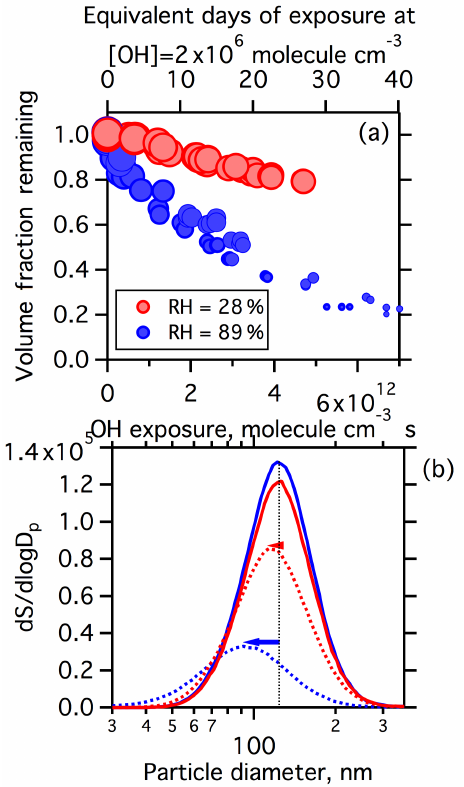
Figure 3. Influence of photochemical aging on SOA volume for low-RH (red) or high-RH (blue) conditions. (a) The volume frac- tion remaining as a function of OH exposure. The sizes of mark- ers correspond to particle size. (b) Example surface-weighted size distributions of particles before OH exposure (solid lines) and after oxidation at an OH exposure = 4 . 7 × 10 12 moleculecm − 3 s (dashed